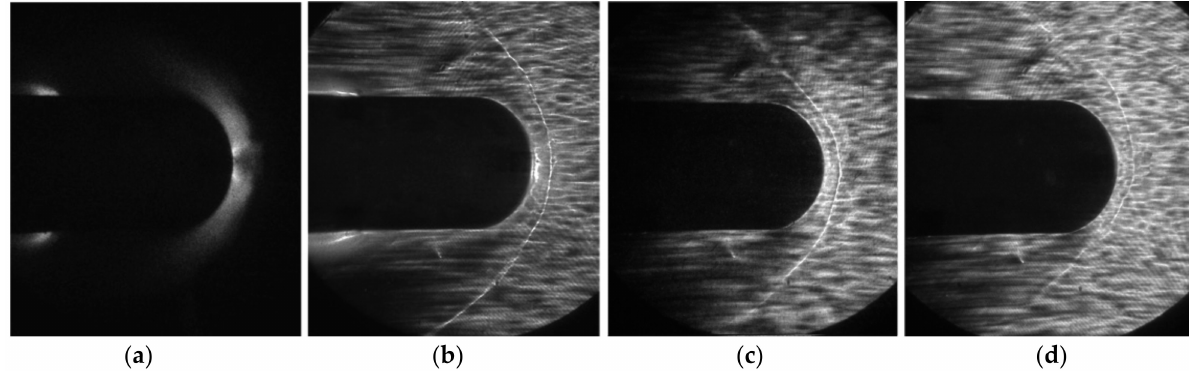
Figure 18. Pictures of the supersonic flow around a body at current I = 800 A connected on a three- electrode circuit: ( a ) Glow of a gas discharge; ( b ) Without magnetic field; ( c ) MHD action at current from the central electrode to the side one and B = 1.3 T; ( d ) MHD action at current from the side electrodes to the central one and B = 1.3